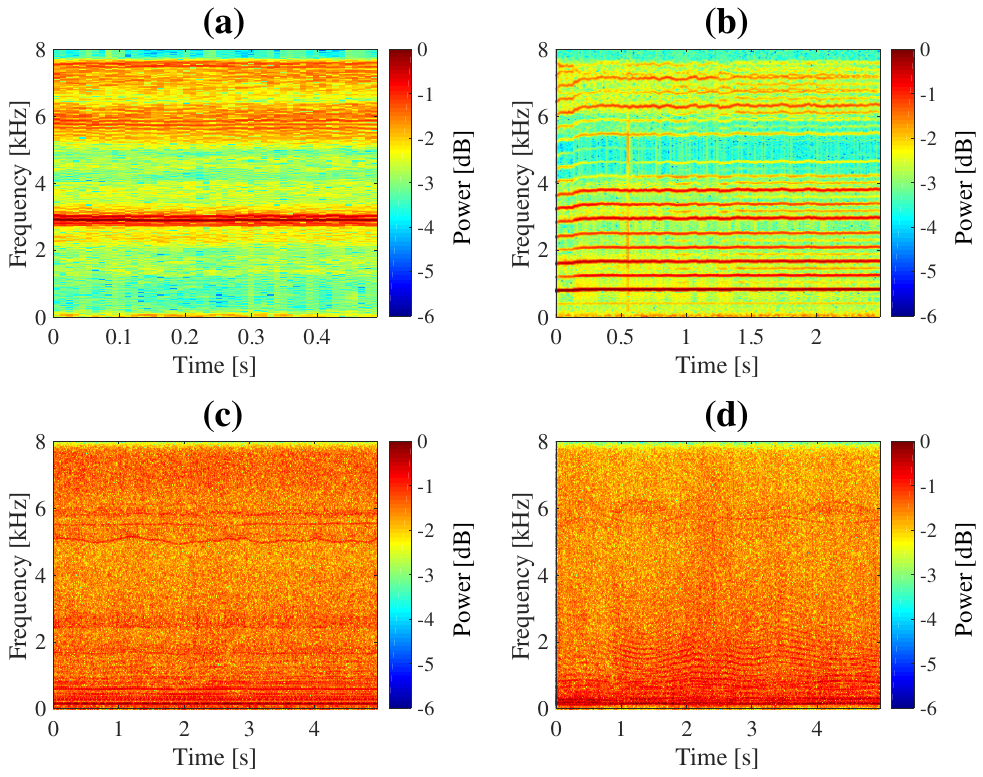
Figure 10. Spectrograms. ( a ) whistle; ( b ) voice; ( c ) noise of UAV recorded by hexagonal microphone array; ( d ) noise of UAV recorded by spherical microphone